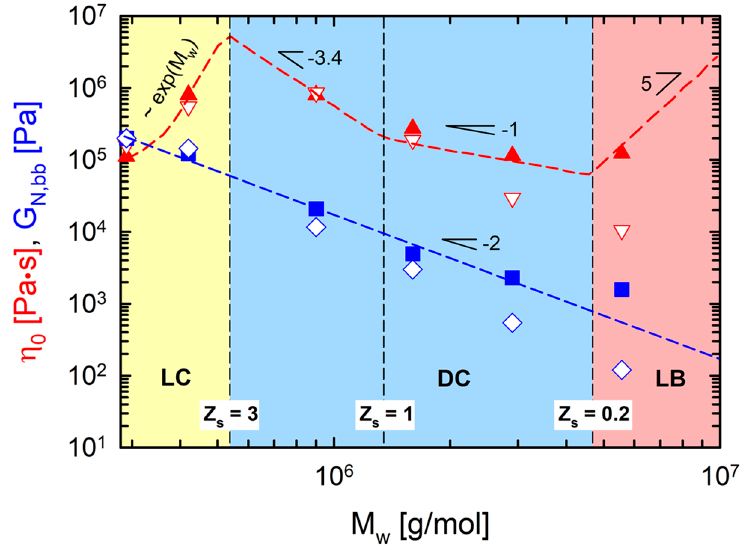
Figure 4. Zero-shear viscosity η 0 and diluted backbone plateau modulus G N,bb as functions of the total molecular weight M w . Filled symbols are the experimental data while unfilled symbols are the model predictions. Dashed lines are drawn to guide the eye.